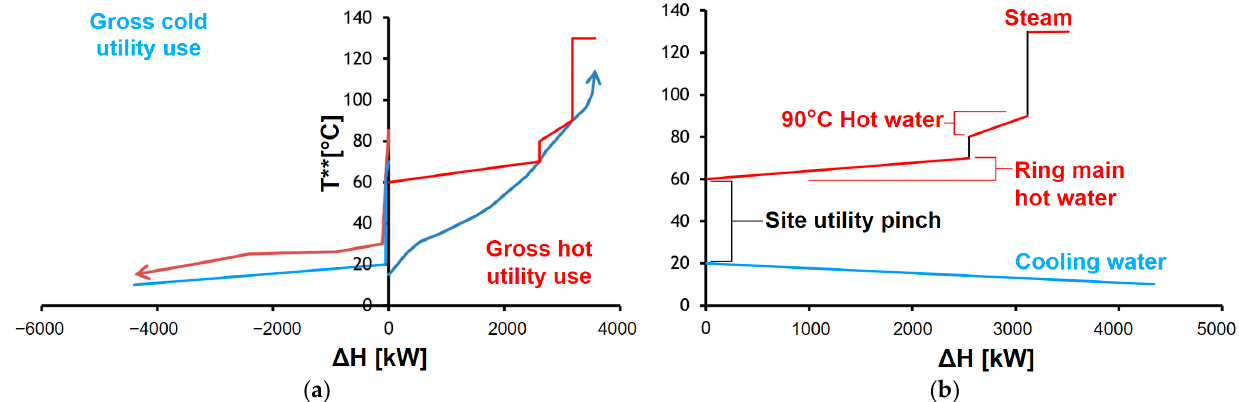
Figure 7. ( a ) Total Site Plot with MVR implemented. The red lines on the Gross cold utility use side of the plot represent process streams that require cooling, and the blue lines represent the cold utility streams that would be required to carry out this cooling. The blue lines on the Gross hot utility use side of the plot represent process streams that require heating, and the red lines represent the hot